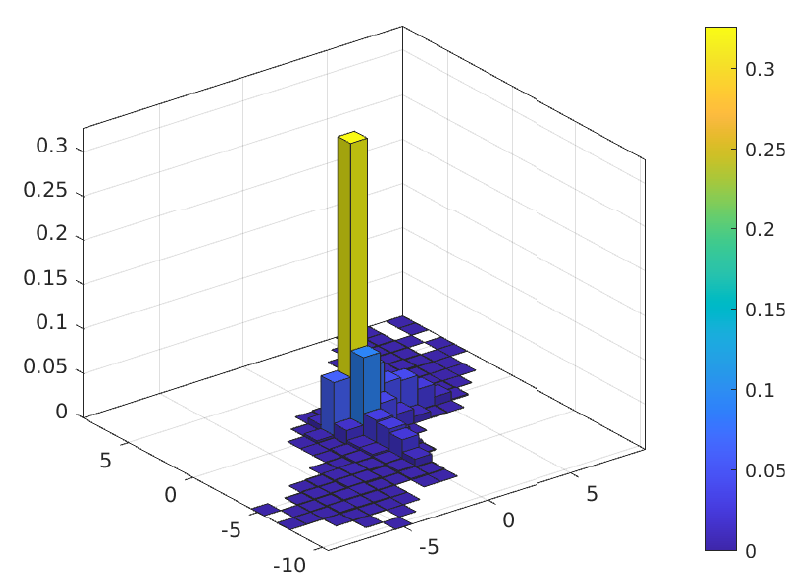
Figure 6. PMF of the TO estimation error for SMC at E b / N 0 = 10 dB.